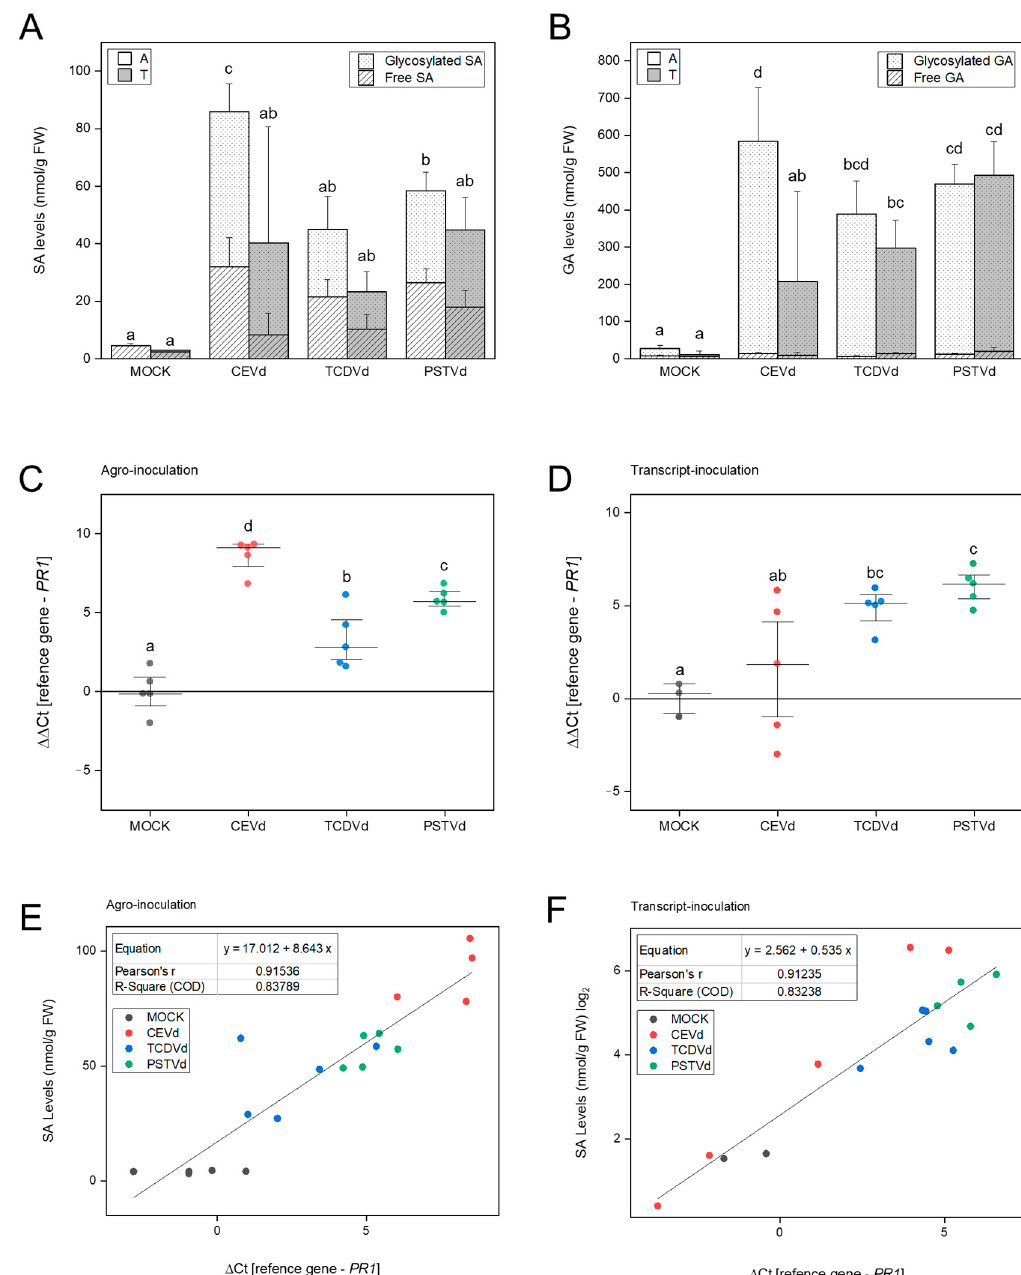
Figure 4. Activation of plant defense response in Rutgers tomato plants infected with CEVd, TCDVd, or PSTVd. ( A ) Levels of free and glycosylated SA and ( B ) GA in mock agro- and transcript-inoculated Rutgers leaves, respectively, infected with CEVd, TCDVd, and PSTVd at 25 days post inoculation (dpi). Data correspond to the mean ± SD of 5 biological replicates. Total levels of SA and GA were analyzed using an ANOVA test with a Tukey post-hoc and different letters indicate significant differences ( p ≤ 0.05). Real-time PCR analysis of PR1 expression in agro-inoculated ( C ) and transcript-inoculated ( D ) plants with mock, CEVd, TCDVd, and PSTVd at 25 dpi. Correlation value and equation between the relative induction of PR1 and total SA levels in agro-inoculated ( E ) and transcript-inoculated ( F ) tomato plants. Data were analyzed using a Mann–Whitney test and different letters indicate significant differences ( p ≤